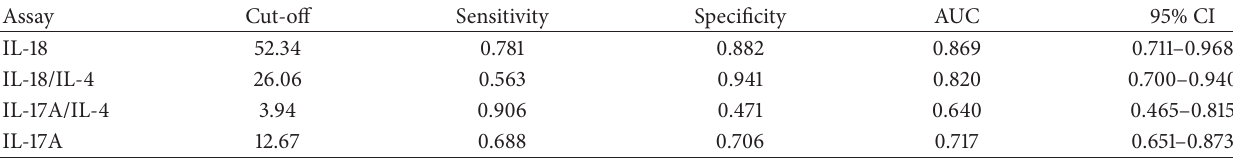
Table 3: Serum IL18, IL-18/IL-4, and IL-17A/IL-4 assays using optimal cut-off values. Assay